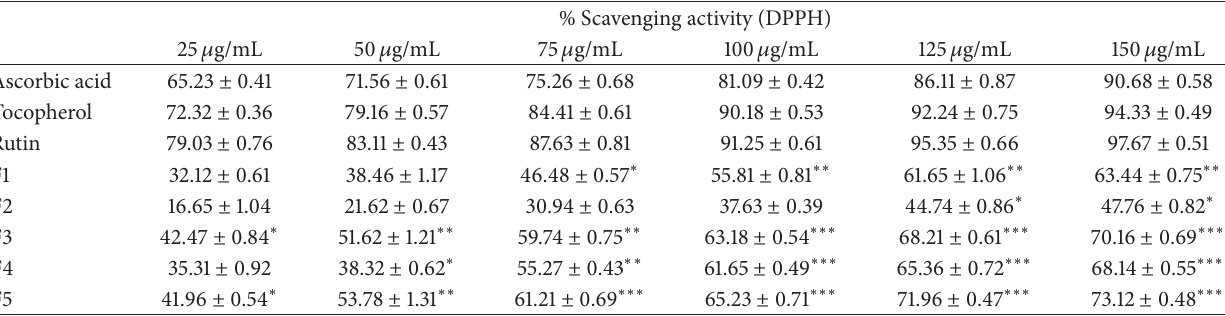
Table 3: DPPH radical scavenging activity of flavone derivatives.